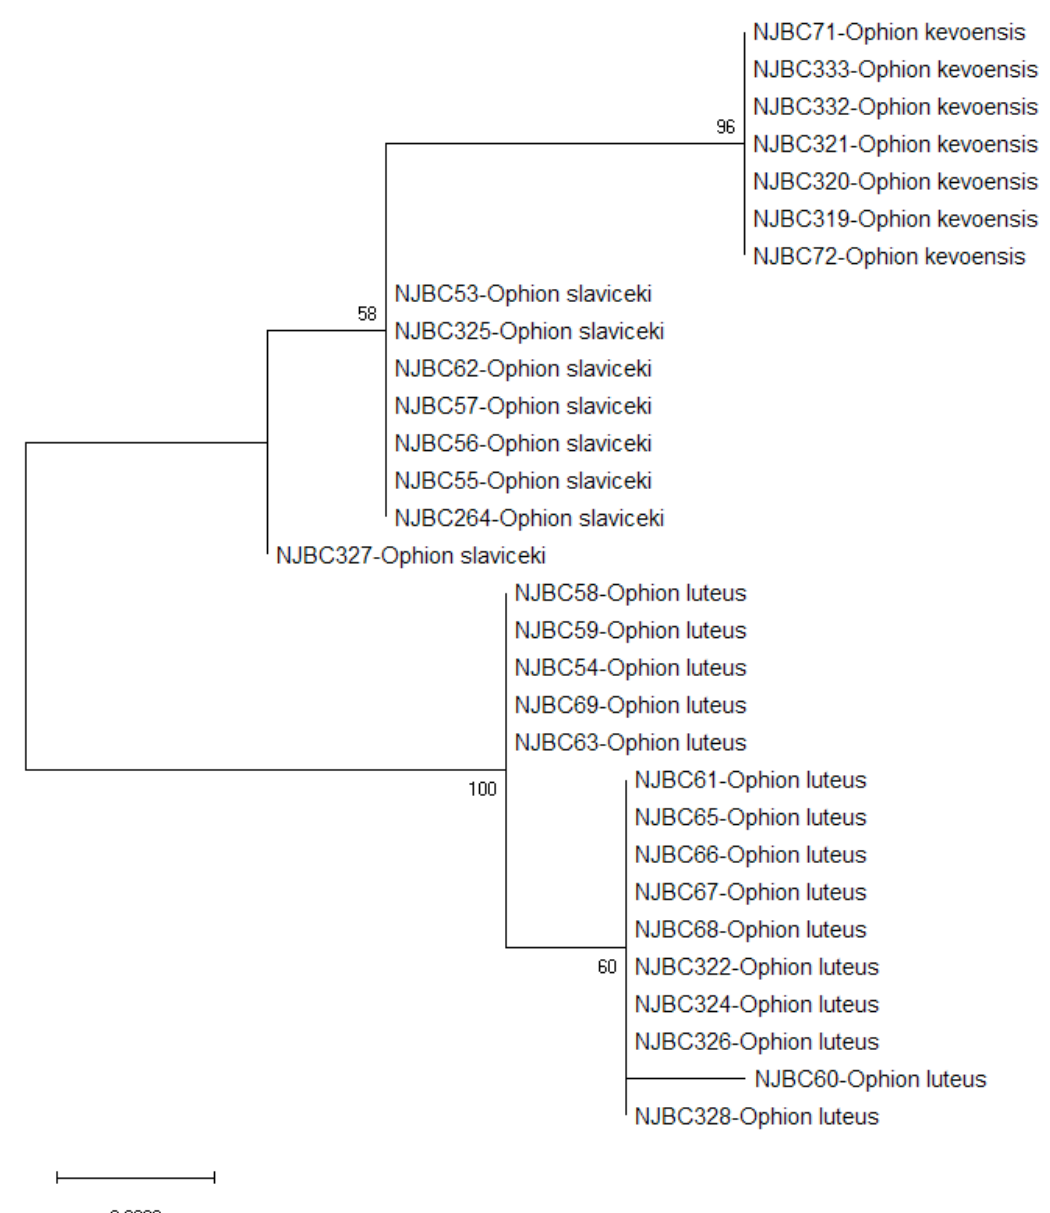
Fig. 3. Phylogeny of the Ophion luteus aggregate (BIN. BoLD:ACF9514) as obtained from cytochrome oxidase 1 (CoI) sequences. Maximum likelihood tree is shown with clade support based on 150 bootstrap iterations using the general Time reversible model and analysed with MEgA-X. The sample ids “NJBC” refer to the BoLD